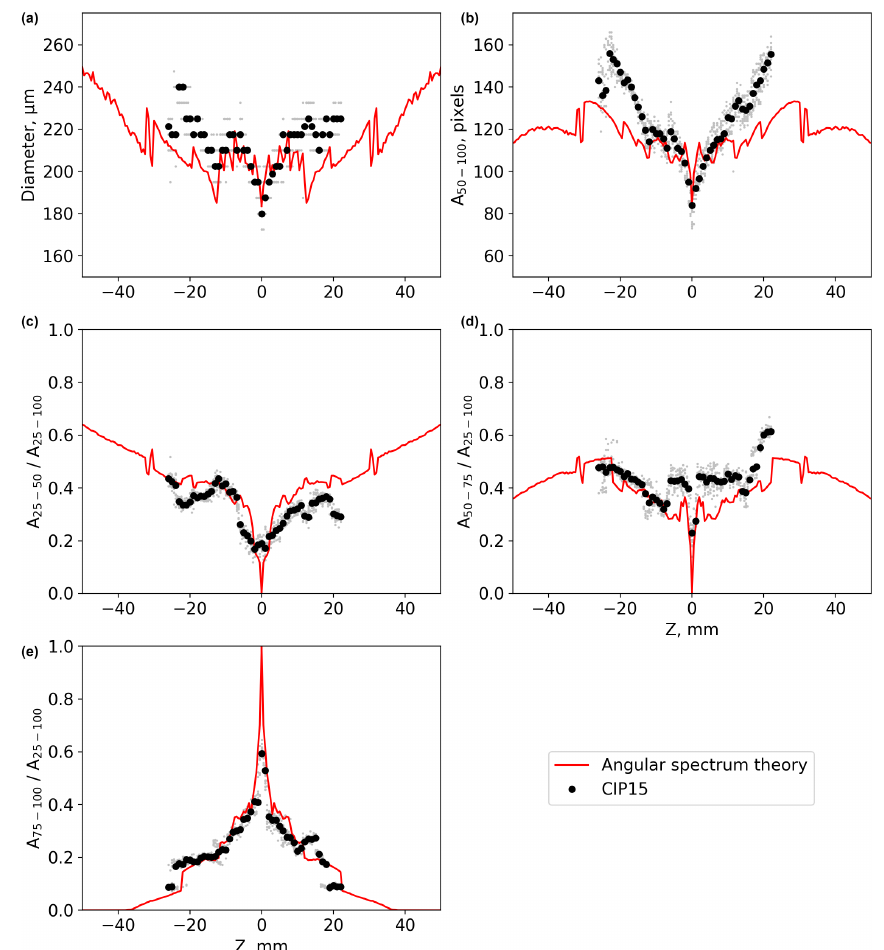
Figure 6. Same as Fig. 5 but for the ice crystal analogue